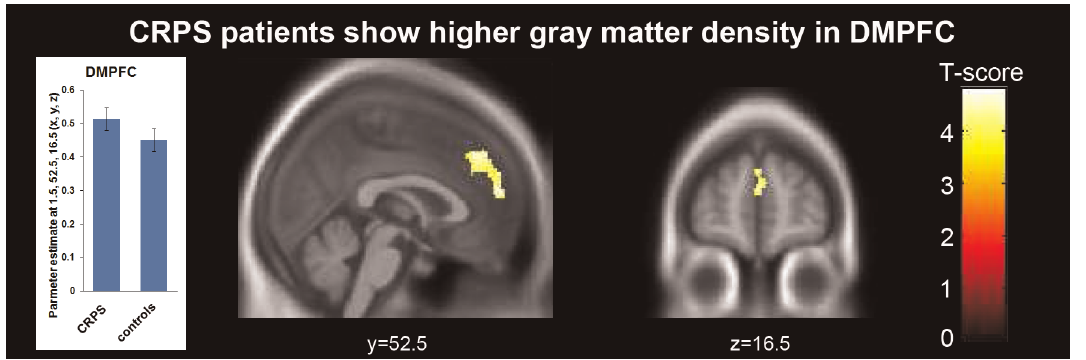
Figure 1. Comparing CRPS patients to age and gender matched controls by VBM whole brain analysis identified one significant cluster with increased gray matter density in CRPS patients located in the DMPFC (peak voxel-level: 1.5, 52.5, 16.5 (x, y, z, mm), T=4.42, p , 0.001 uncorrected, cluster-level: 556 voxels, p=0.03 FWE corrected). Since we found no link to the individual clinical CRPS features (see Results), the interpretation of this finding remains speculative, but it may point to pain associated altered cognitive processes such as emotional suffering. The bar plot represents estimated gray matter density from the peak voxel. The whiskers indicate the standard error. doi:10.1371/journal.pone.0085372.g001 PLOS ONE |